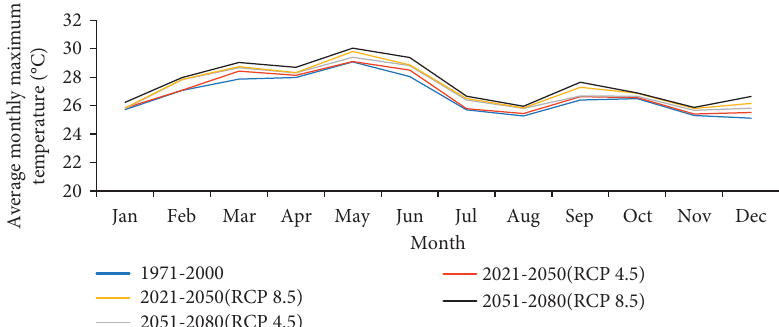
Figure 8: Average monthly maximum temperatures for future